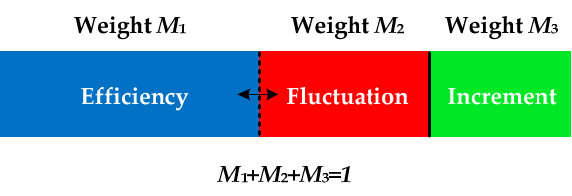
Figure 8. Schematic of dynamic weights in value function.